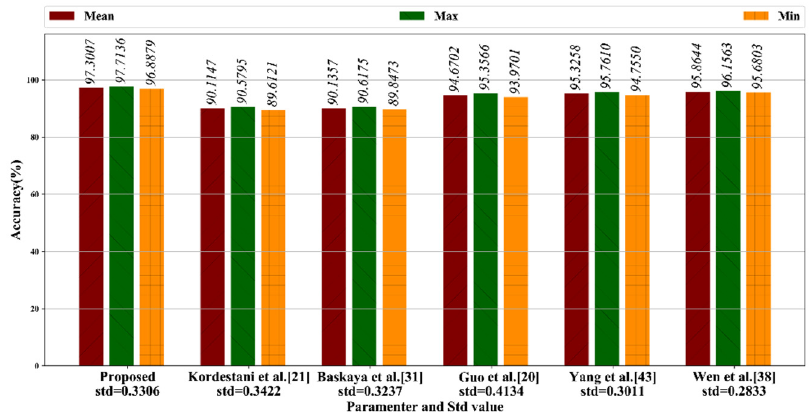
Figure 15. Fault classification accuracy comparison (in percent).